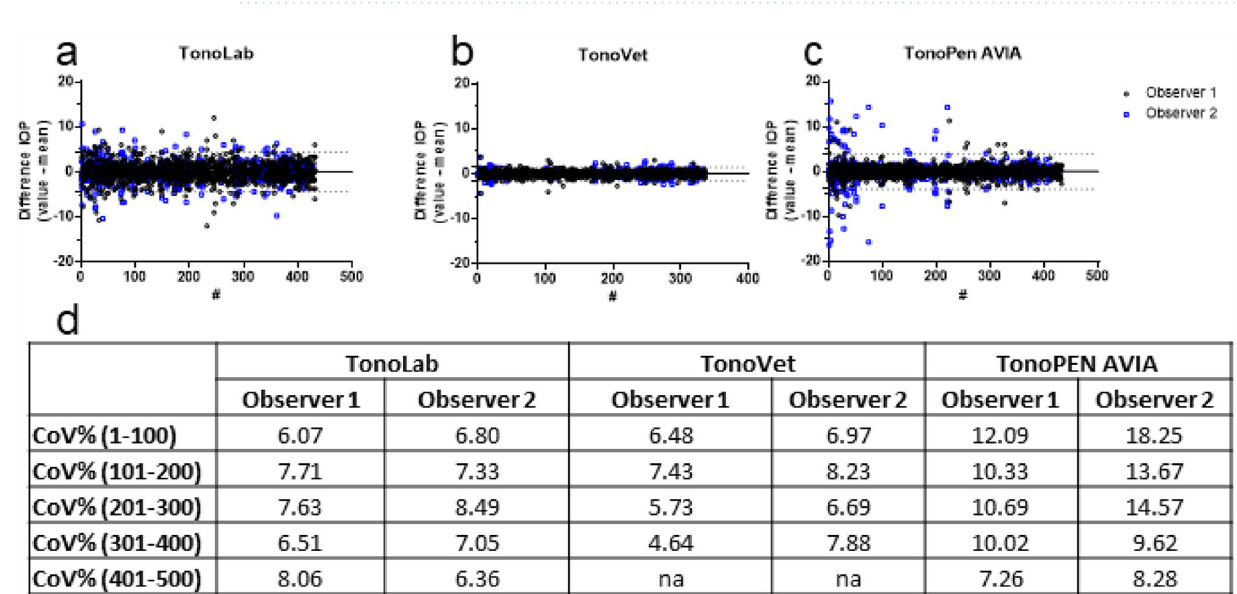
Figure 2. Repeatability of IOP measurements in tonometers (TonoLab ( a , d ), TonoVet ( b , e ), and TonoPEN AVIA ( c , f )) for both observers. Difference per measurement (y-axis) is plotted over the mean IOP (x-axis). Dotted lines represent 1.96 times the SD (95% confidence interval).